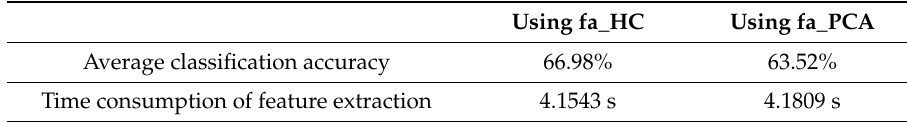
Table 2. Average classification accuracy and time consumption of feature extraction using different simplification methods. fa_HC , acoustic features after hierarchical clustering; fa_PCA , acoustic features after principal factor analysis.